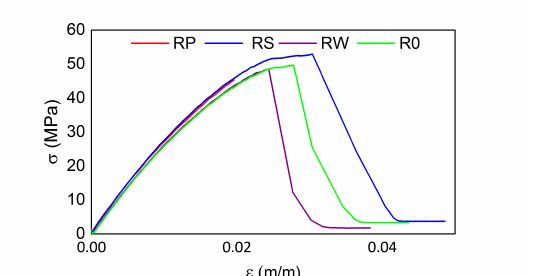
Figure 16. Tensile test results for M3 X samples after exposition on elevated